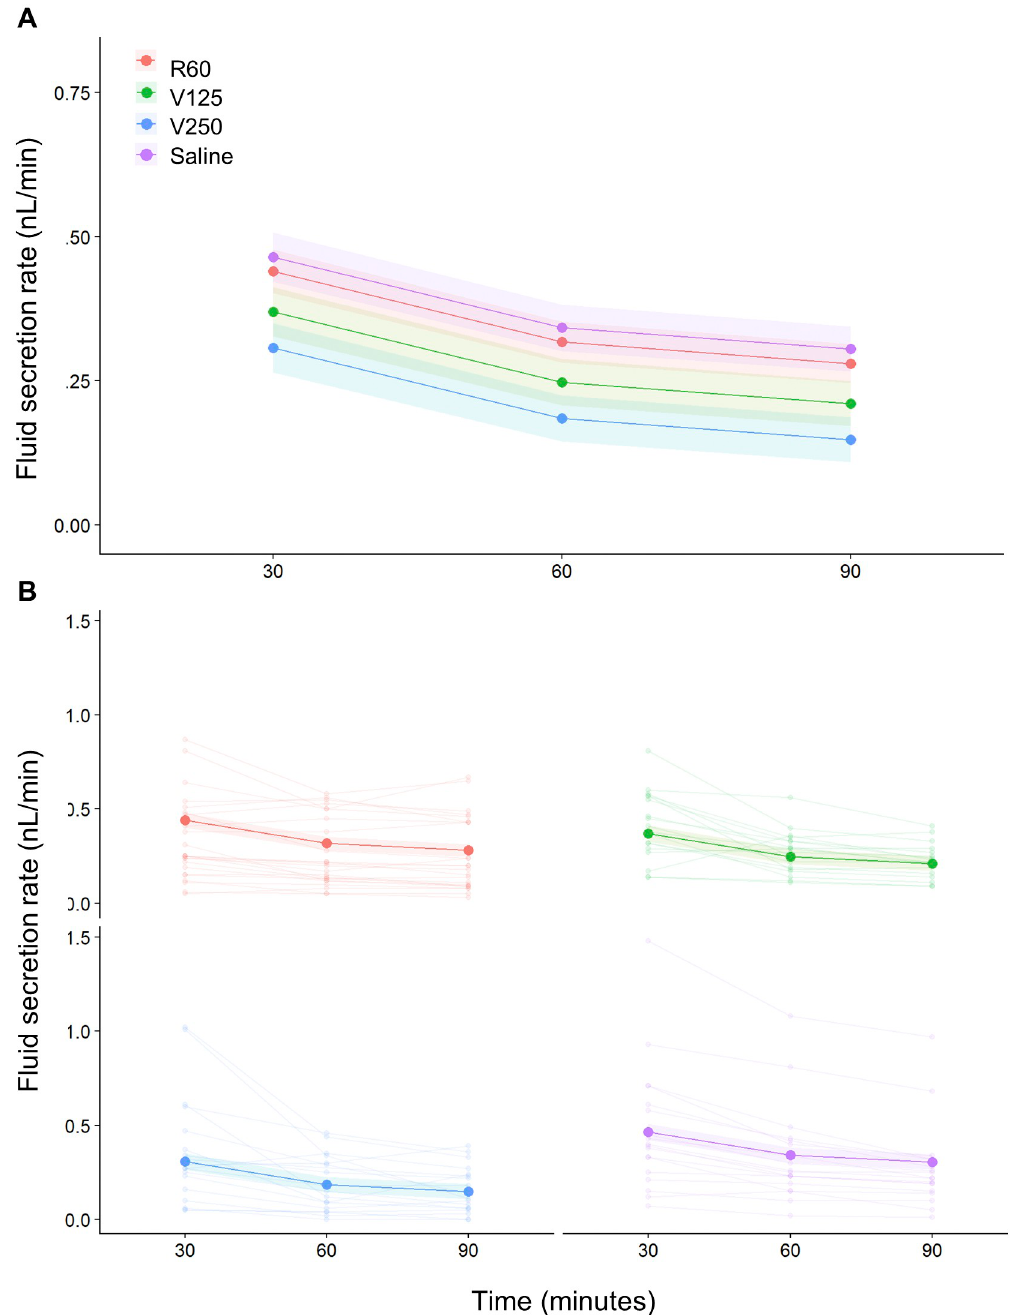
Fig 3. Mean fluid secretion rate of Malpighian tubules during the incubation period. ( A ) The mean fluid secretion rate decreased after 60 minutes of incubation in all the treatments, while it remained steady for the next 30 minutes in all the treatments except in the saline one. Each line with the shaded area around represents the mixed effect model fit with the standard error. ( B ) As in ‘A’, but with the fluid secretion rate of individual tubules shown by pale lines linking smaller dots.